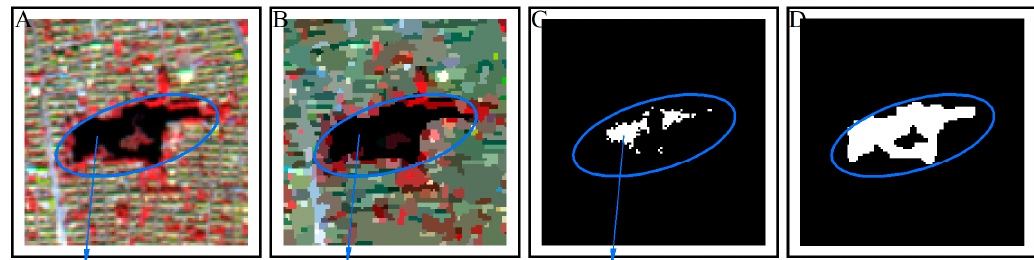
Figure 4. Schematic diagram for the calculation process of the water pixel proportion. ( A ) A pond sample; ( B ) number of pixels of the pond sample object in sub-figure A after segmentation; ( C ) nu-mber of water pixels of the pond sample in sub-figure ( A ), and WI defines the water pixels; ( D ) pix-el ratio for the pond sample calculated by dividing the number of pixels obtained in ( A ) by the number of pixels obtained in ( B ).